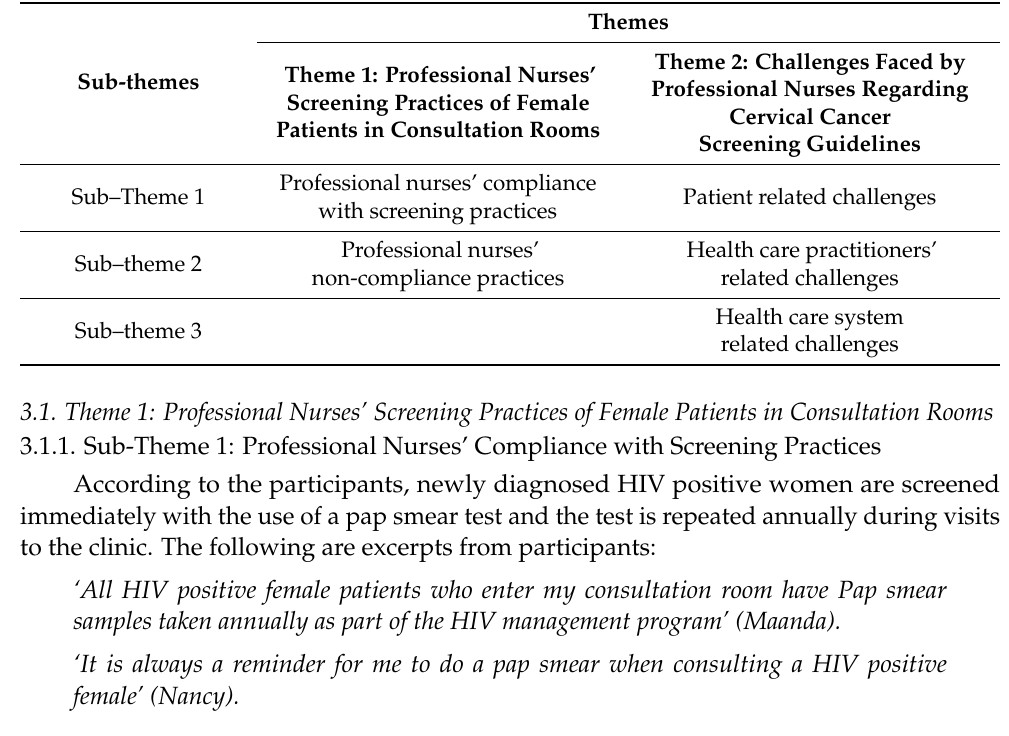
Table 1. Themes and sub-themes generated from the participants’